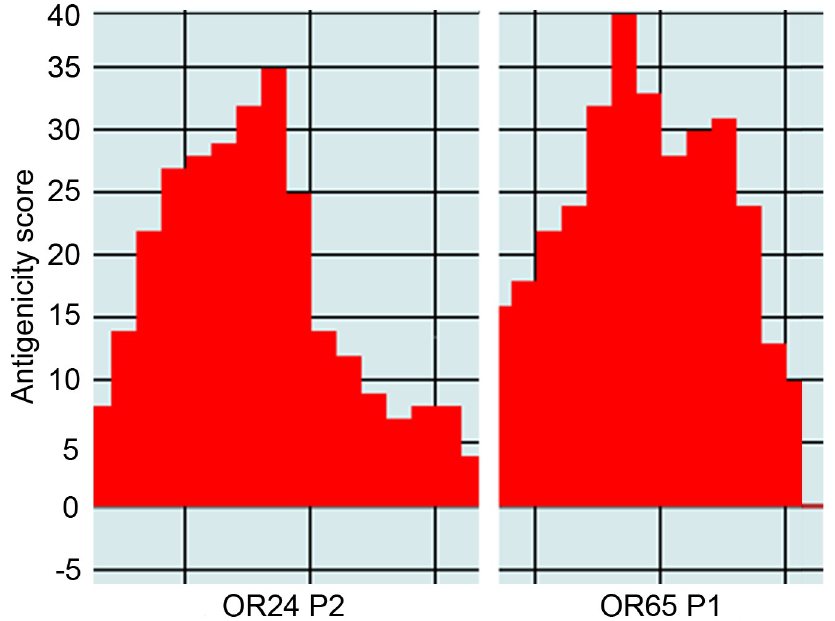
Fig 1. Computer-predicted antigenicity scores for two peptides. One peptide with the highest antigenicity score (calculated by EpiQuest-B) is displayed for each of the two proteins. Polymorphic sequences of OR24 P2 and OR65 P1 show regions of high antigenicity in red. Each red column represents one amino acid from the peptide